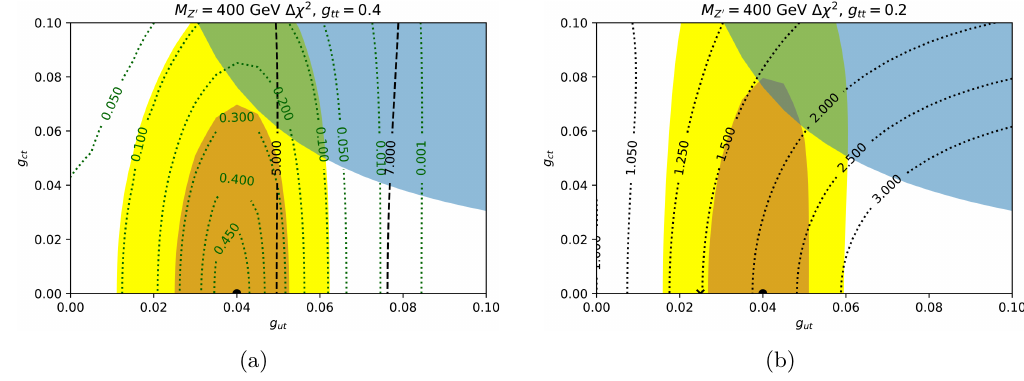
Figure 5 . Idem as in figure 4, but for different points in the ( g ut , g ct ) plane. The blue regions correspond to regions in parameter space disfavoured by D 0 ↔ ¯ D 0 mixing as detailed in section